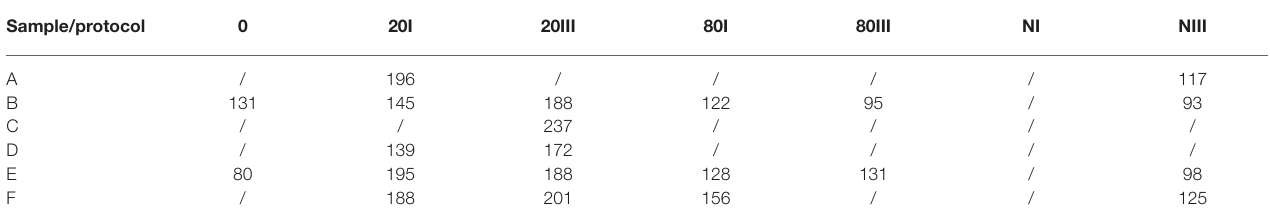
TABLE 1 | The genus numbers measured in each group.